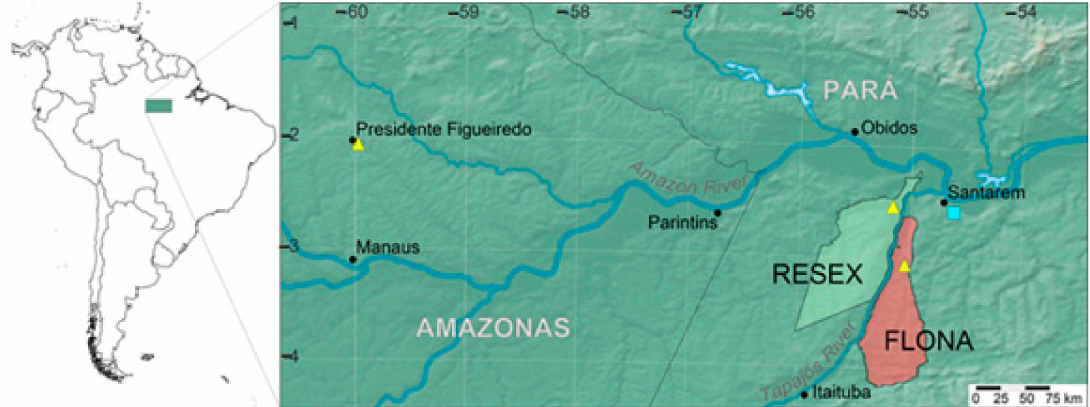
Figure 8. Geographic distribution of the species and samples included in the chemical variation study. The yellow triangles represent Aniba rosiodora , and the blue square represents A. parviflora . The RESEX (Reserva Extrativista Tapaj ó s Arapiuns) and FLONA (Floresta Nacional do Tapaj ó s) preserves are indicated on the west and east banks of the Tapaj ó s River,